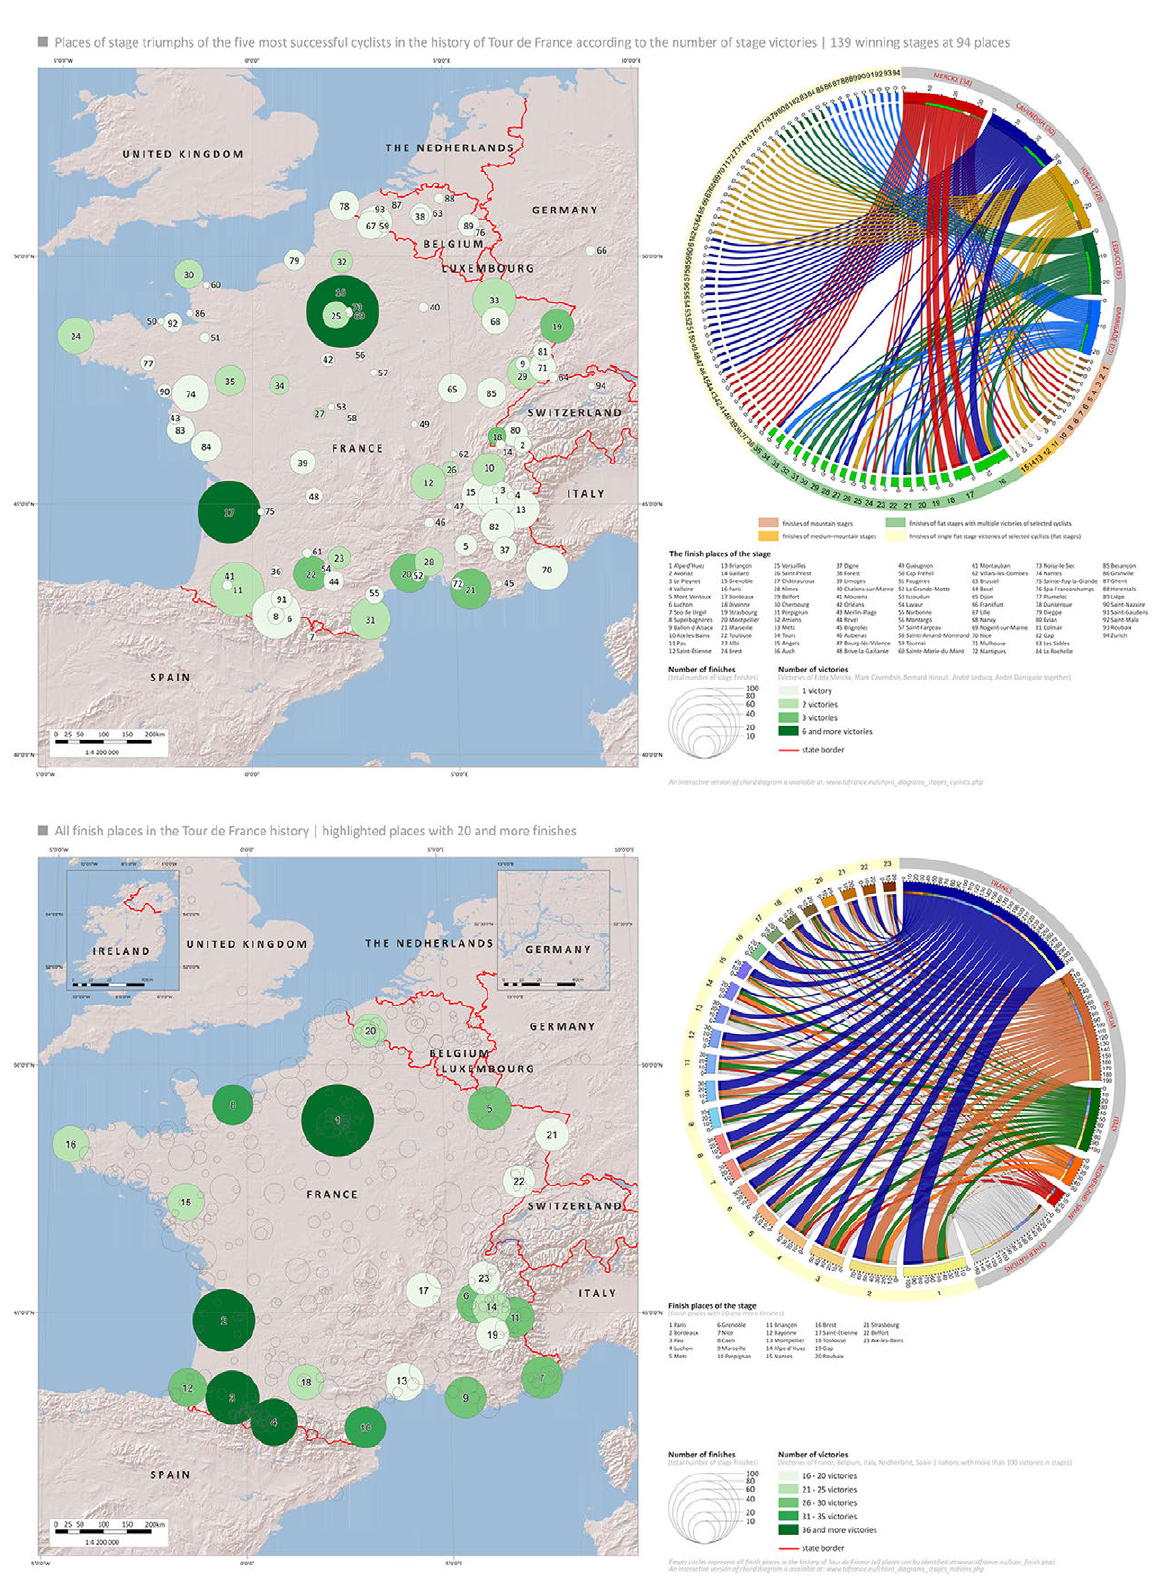
Fig. 5. Preview map of selected historical statistics of Tour de France